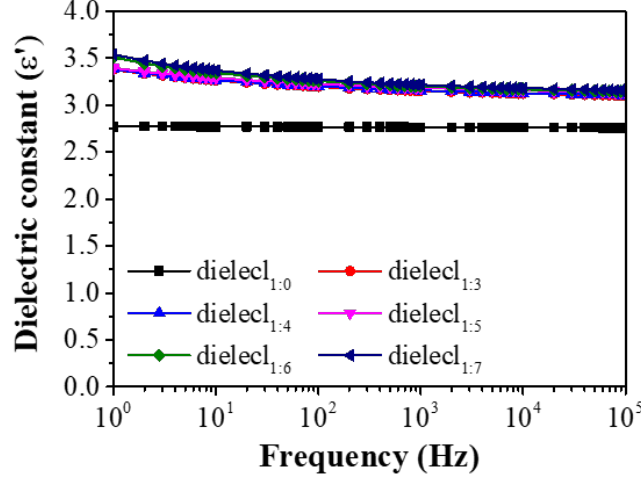
Figure 7. Dielectric properties of the dielectric layer samples.